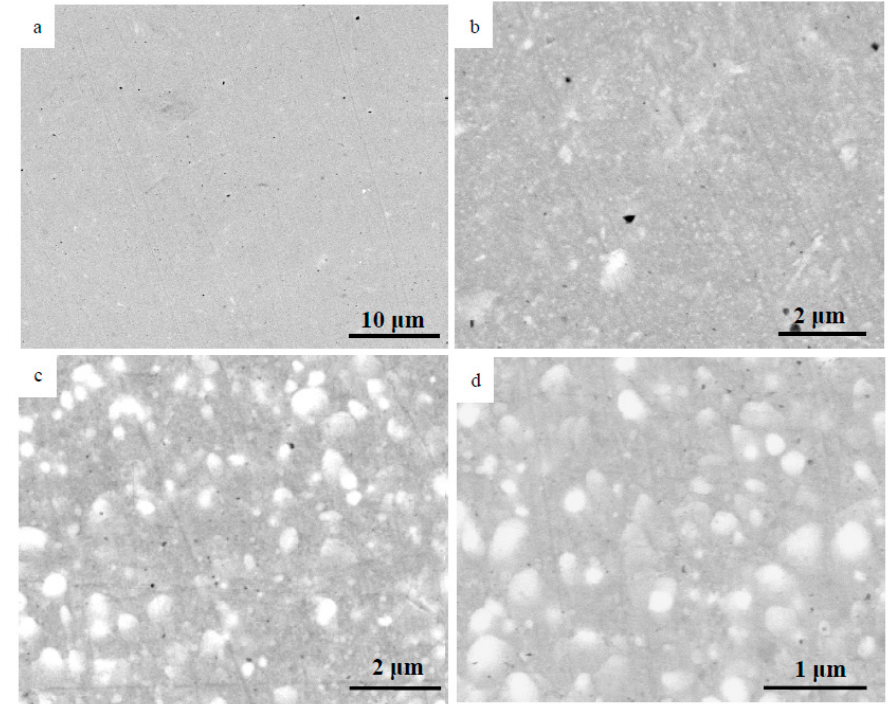
Figure 2. SEM images of MA ‐ ed Cu ‐ Nb powders annealed under different conditions: ( a ) 400 °C, 1 h; ( b ) 700 °C, 1 h; ( c ) 900 °C, 1 h; ( d ) 900 °C, 3 h.